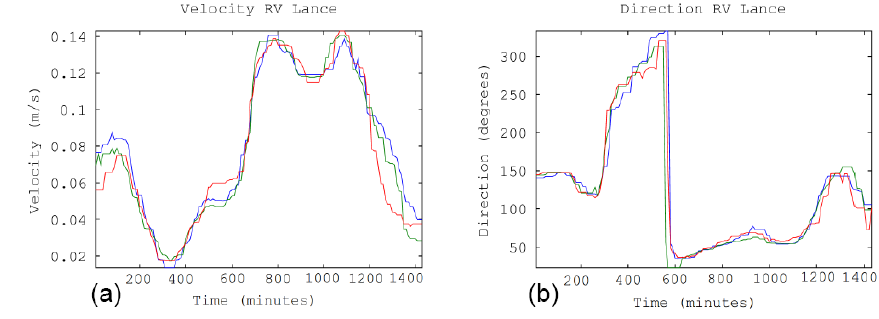
Figure 16. Velocity (a) and direction (b) for the RV Lance 2015 case selected three VBs. The direction is in degrees.